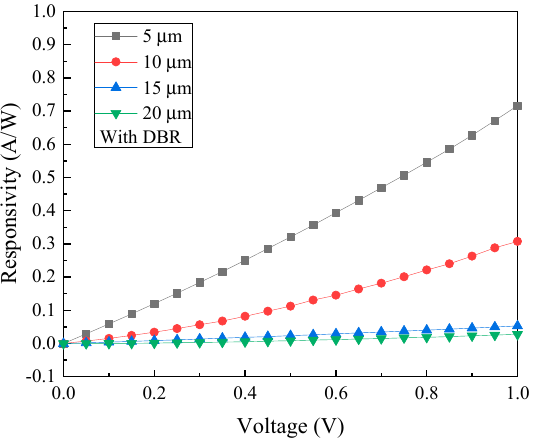
Figure 11. The responsivity of GeSn MSM PD with DBR structure and four different electrode sizes under 2000 nm illumination.